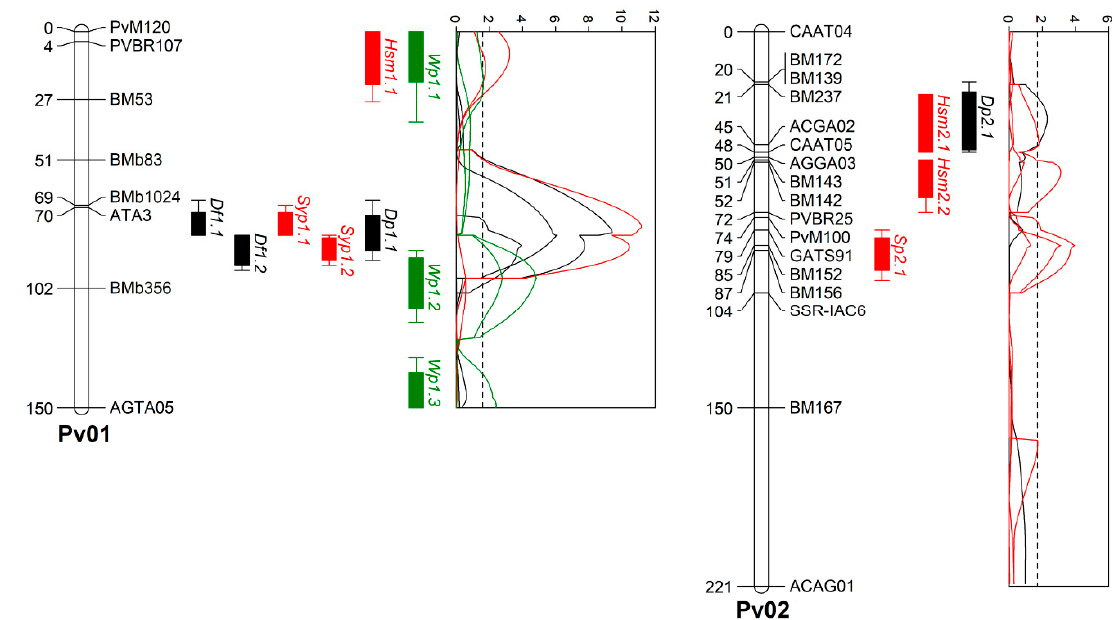
Figure 1. Common bean linkage groups Pv01 and Pv02 showing quantitative trait loci (QTLs) for physiology-associated traits (green), phenological traits (black), and yield-associated traits (red) in ‘Tiber’ × ‘Starozagorski’ genetic linkage map detected with single environment analysis. The rest of the linkage groups are presented in Figure S2. For QTL names, see Table 1.